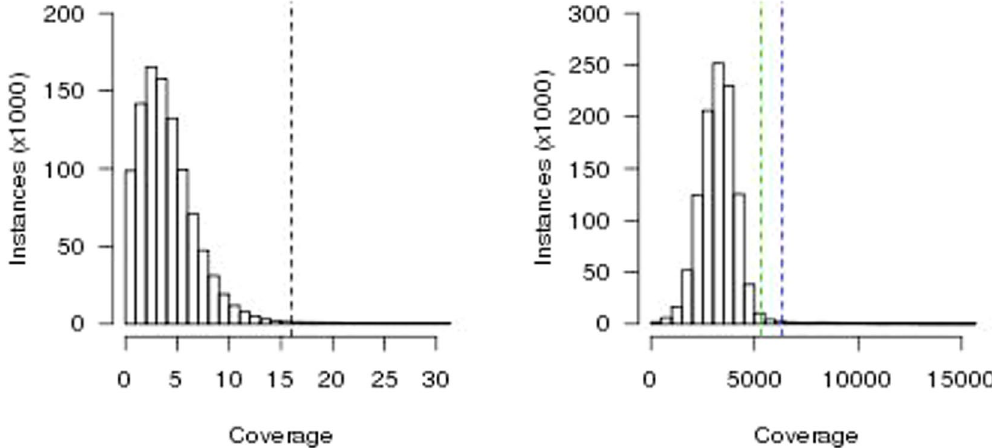
Figure 3. Sequencing Depth Histograms. Histograms of the instances, in increments of 1000, of a given sequencing depth upon calculating sequencing depth for every position in the genome are shown for ( A ) the depletion data published in Ioannidis et al . 17 and ( B ) the capture data published in Geniez et al . 31 . In panel A, the previously established 17 threshold for predicting a nuwt in the depletion data is shown with a dashed black line. In panel B, the second and third standard deviations from the mean are shown with dashed green and blue lines, respectively.